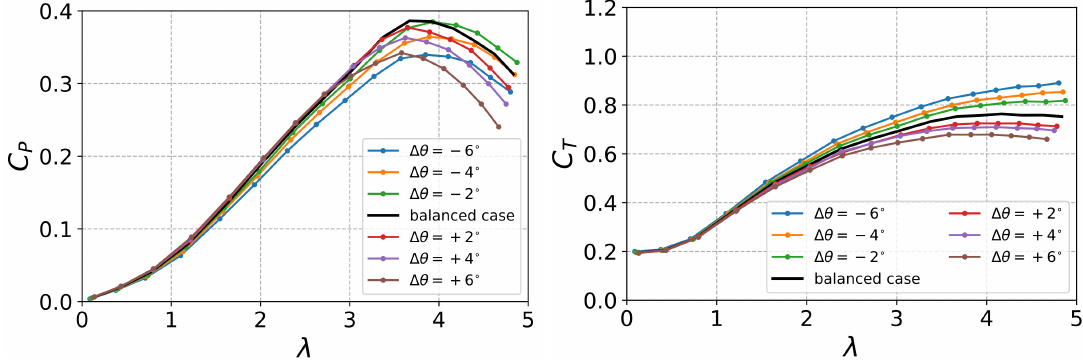
Figure 7. Experimental C P and C T at variable tip speed ratios and pitch imbalances from the optimal collective pitch θ = + 2 ◦